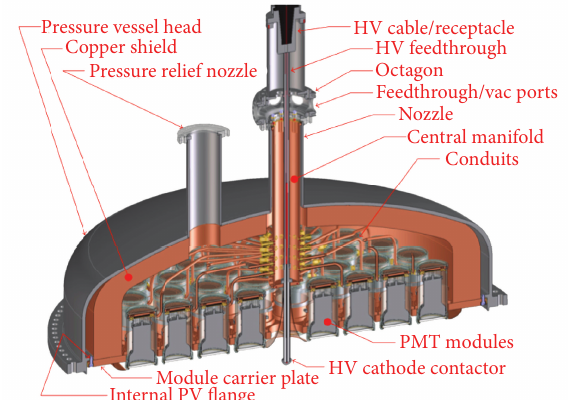
Figure 13: The full energy plane of NEXT- 100 mounted in the vessel